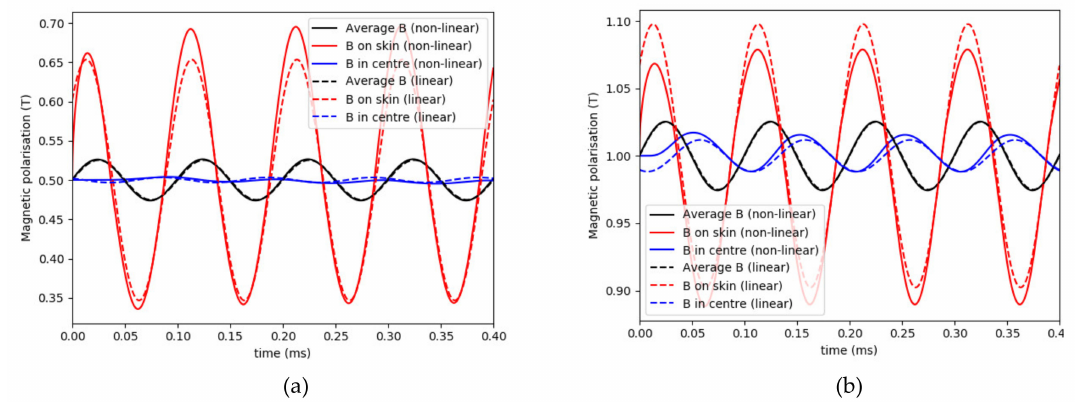
Figure 4. Polarisation waveforms in the material (near centre, near skin and average) for an average waveform of 0.025 T at 10 kHz, superposed on a DC bias polarisation of ( a ) 0.5 T and ( b ) 1